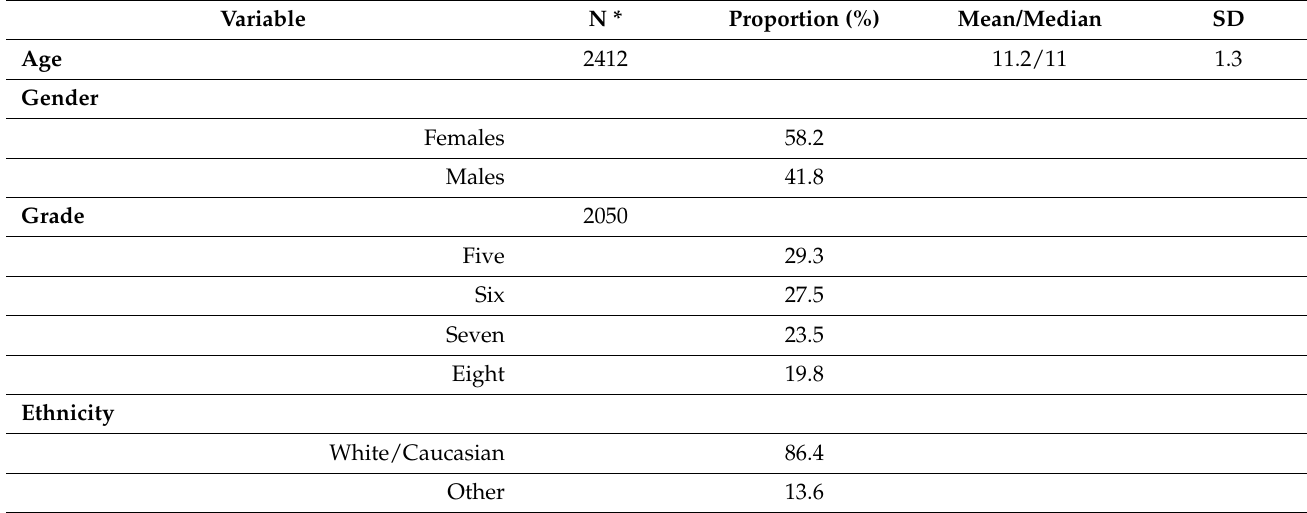
Table 1. Sociodemographic characteristics of the sample (N =